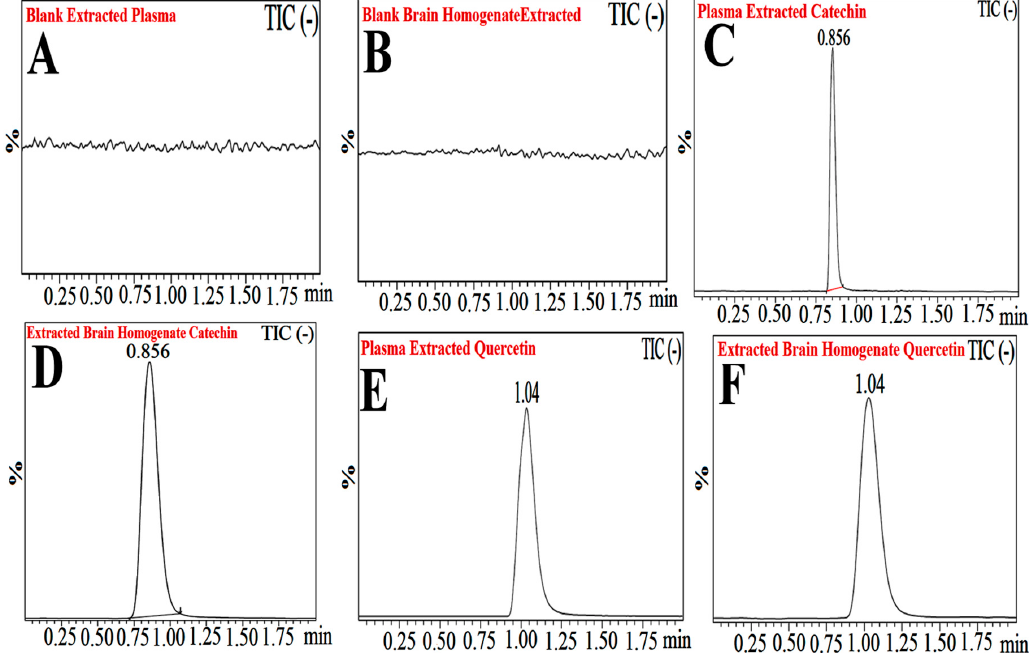
Figure 10. Mass spectrum of, ( A ) quercetin (IS) precursor ion (protonated precursor [M–H] − ions at m / z 301.21 and ( B ) internal standard (IS) product ion (major fragmented product ions at m / z 151.21) showing fragmentation transitions. Pharmaceutics 2020 , 12 , 203